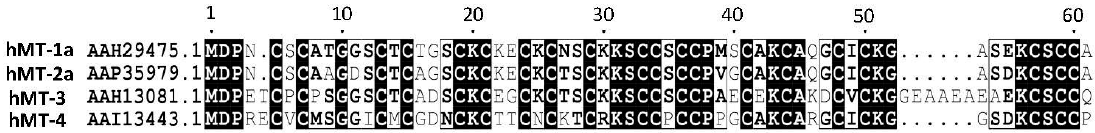
Figure 1. Clustal Omega sequence alignment of the major human metallothionein isoforms with conserved amino acids highlighted in black. Generated with ESPript 3.0.